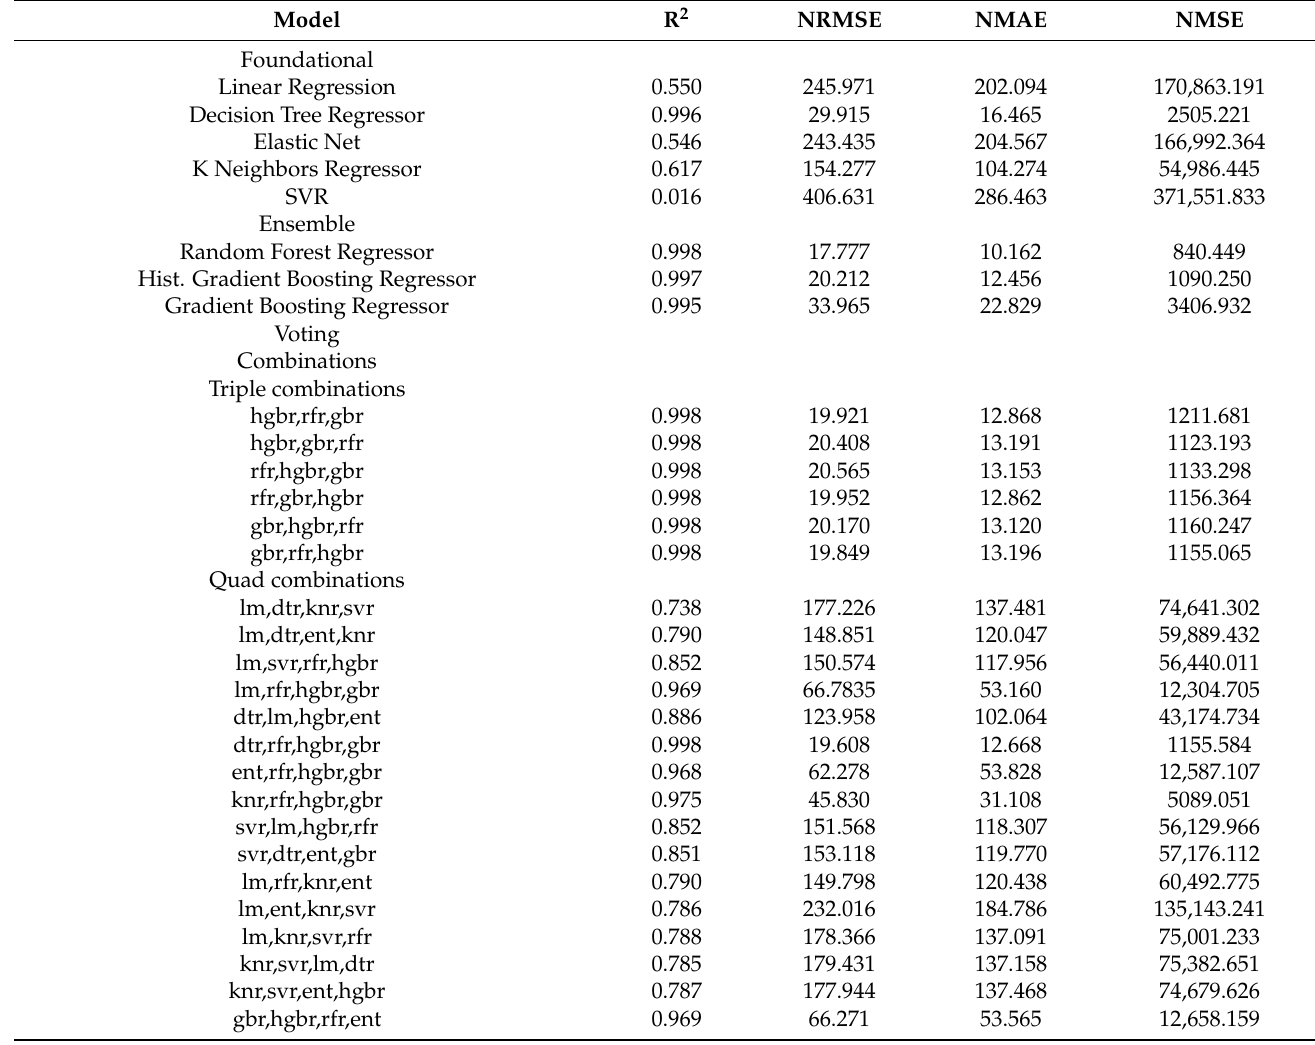
Table 4. Performance results of the